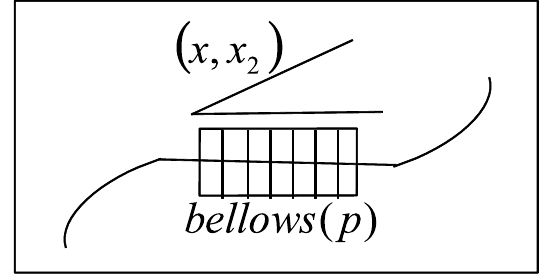
Fig. 3. Bellows angles x and x